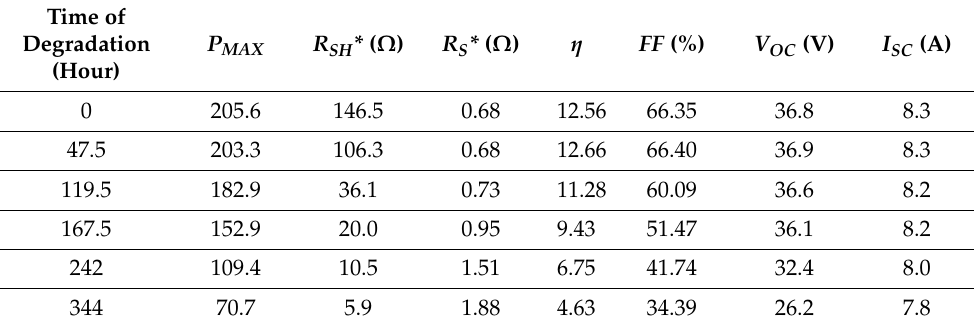
Figure 13. Photovoltaic module parameters during degradation and regeneration. Table 1. Module parameters measured with Pasan SunSim IIIc during degradation. Time